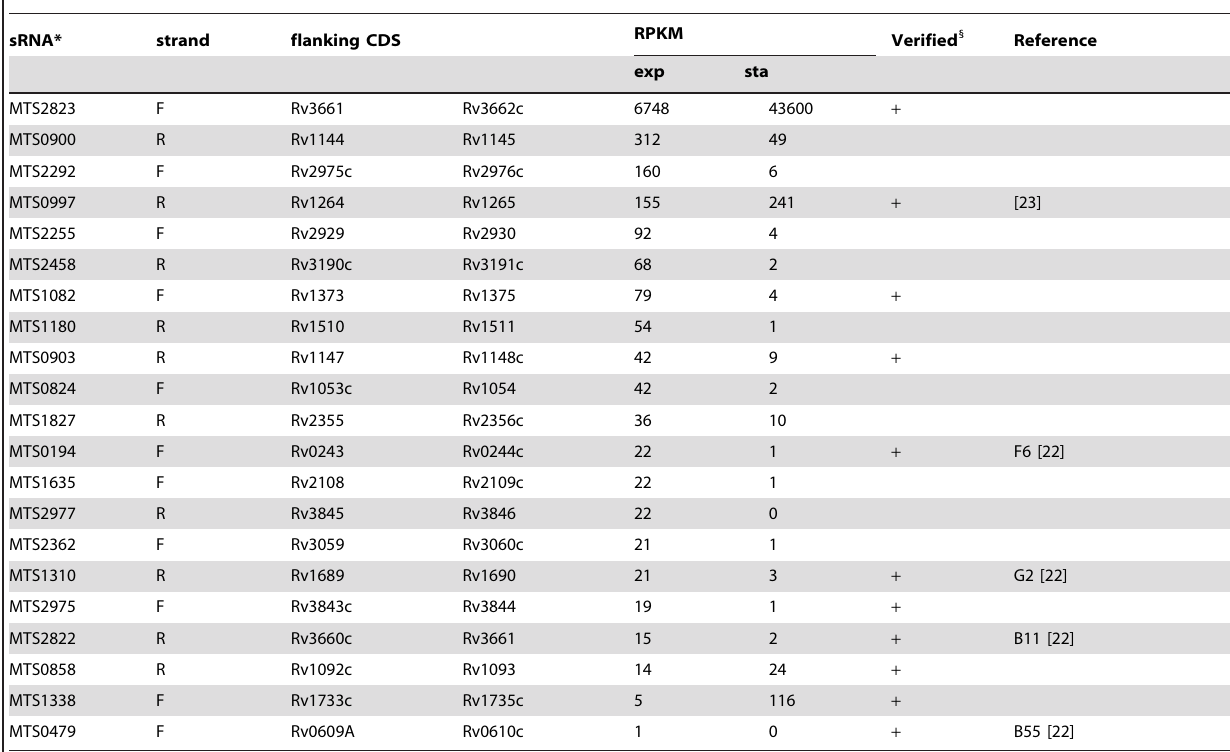
Table 10. Intergenic sRNA candidates ranked according to RPKM.